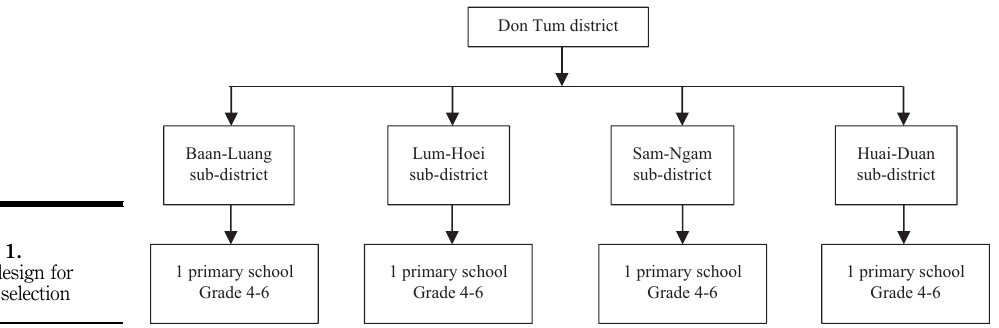
Figure 1. Study design